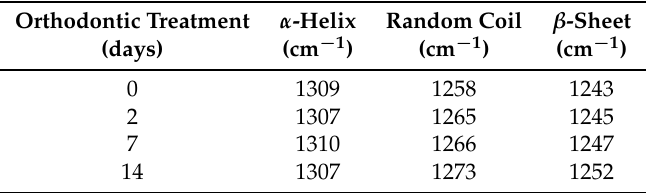
Table 3. Amide III band deconvolution of PDL samples at different stages of orthodontic treatments. Lorentzian functions were used in the fitting